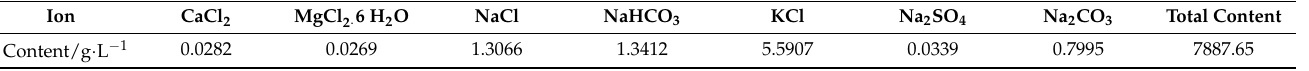
Table 4. Ionic composition of simulated formation